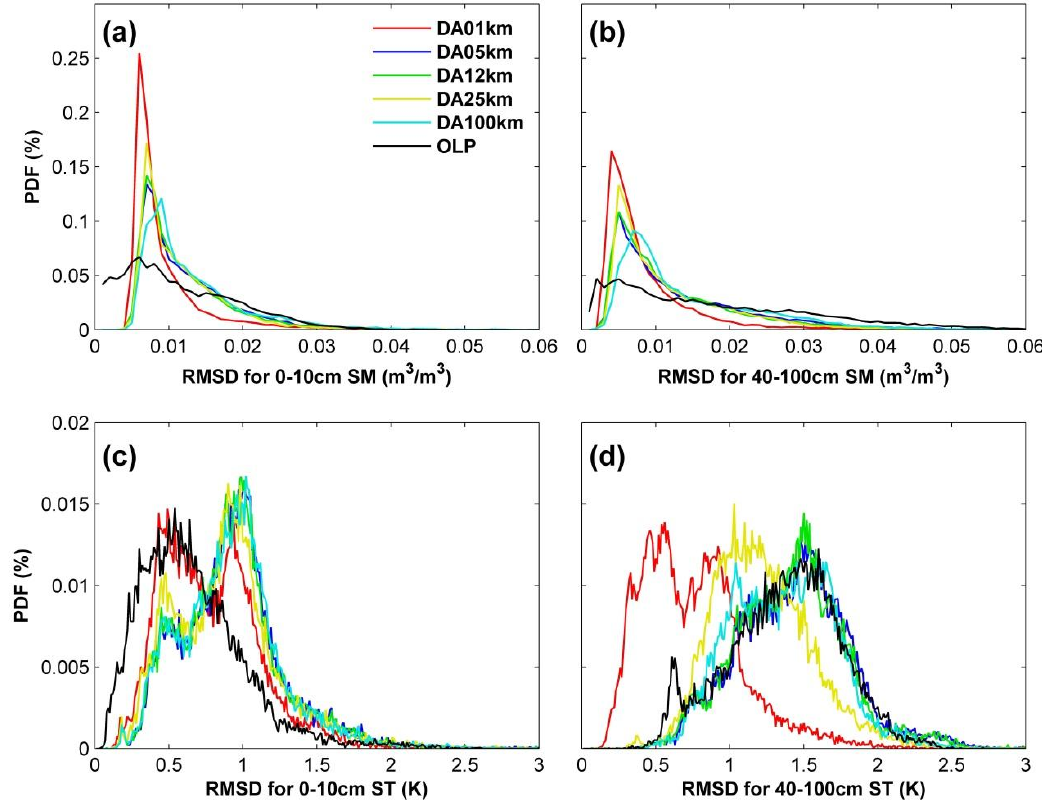
Figure 3. With respect to the CTR run, the study domain-averaged probability density function (PDF) as a function of RMSD during 2015 to 2018 period for: ( a ) 0–10 cm soil moisture (SM), ( b ) 40– 100 cm SM, ( c ) 0–10 cm soil temperature (ST), and 40–100 cm ST over 2015–2018